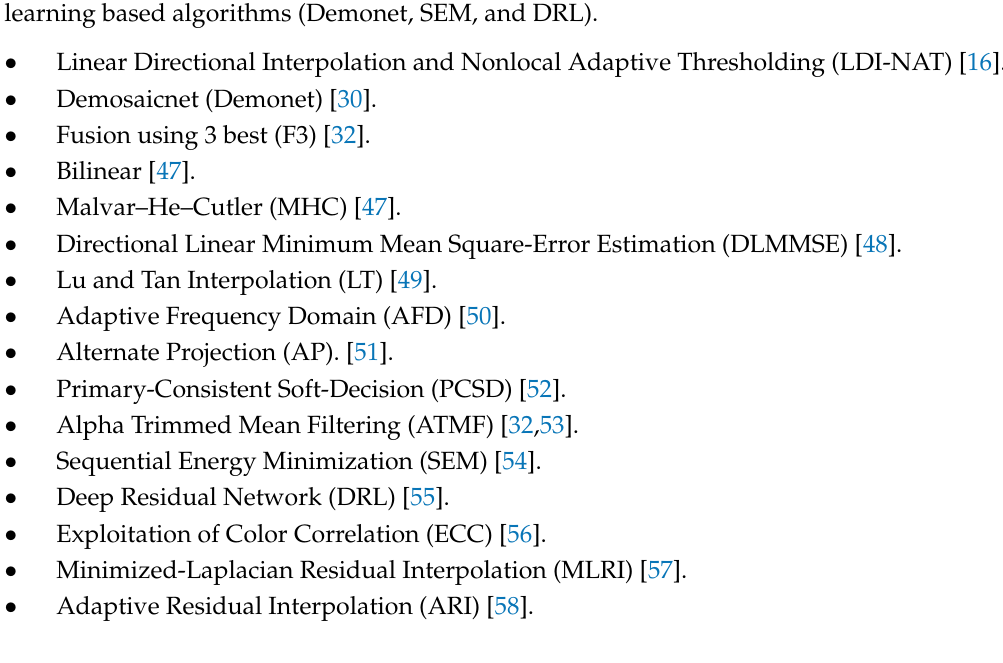
Figure 19. Visual comparison of three high performing demosaicing algorithms at 20 dBs SNR (Poisson noise). The top row is the bird image and the bottom row is the lighthouse image. ( a ) Ground Truth; ( b ) Demonet + GFPCA; ( c )ATMF; ( d ) F3.